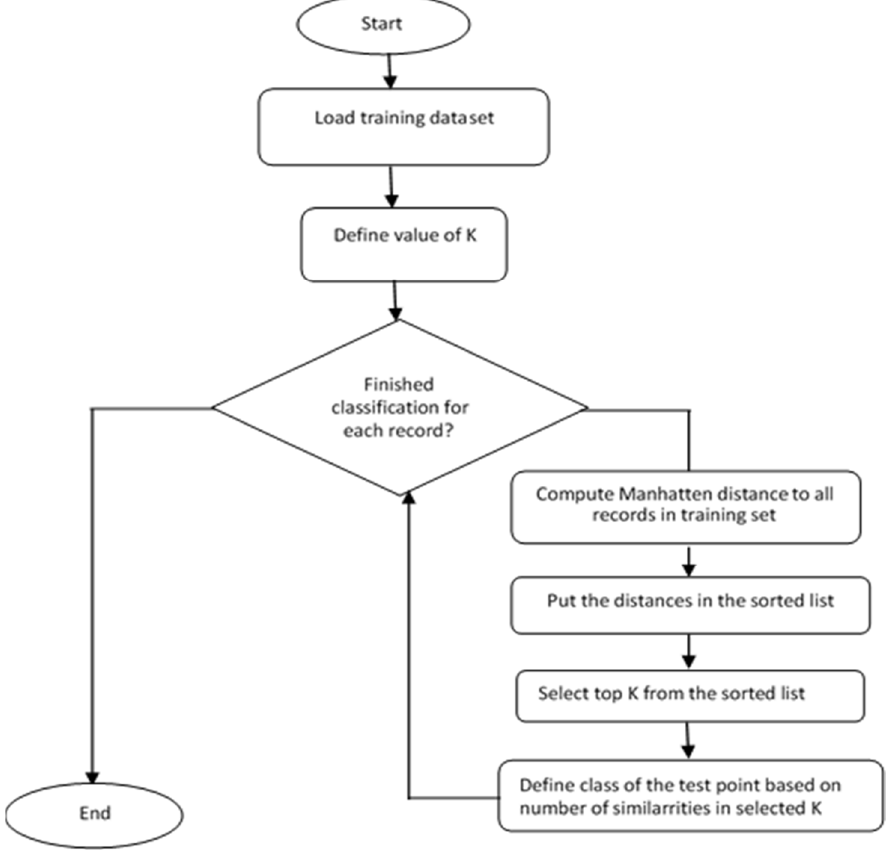
Figure 11. Flowchart of the k-nearest neighbor regression procedure.